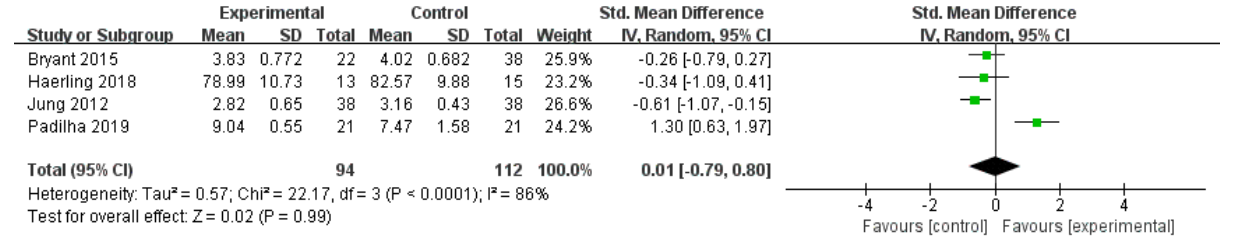
Figure 6. Forest plot of virtual reality on satisfaction.